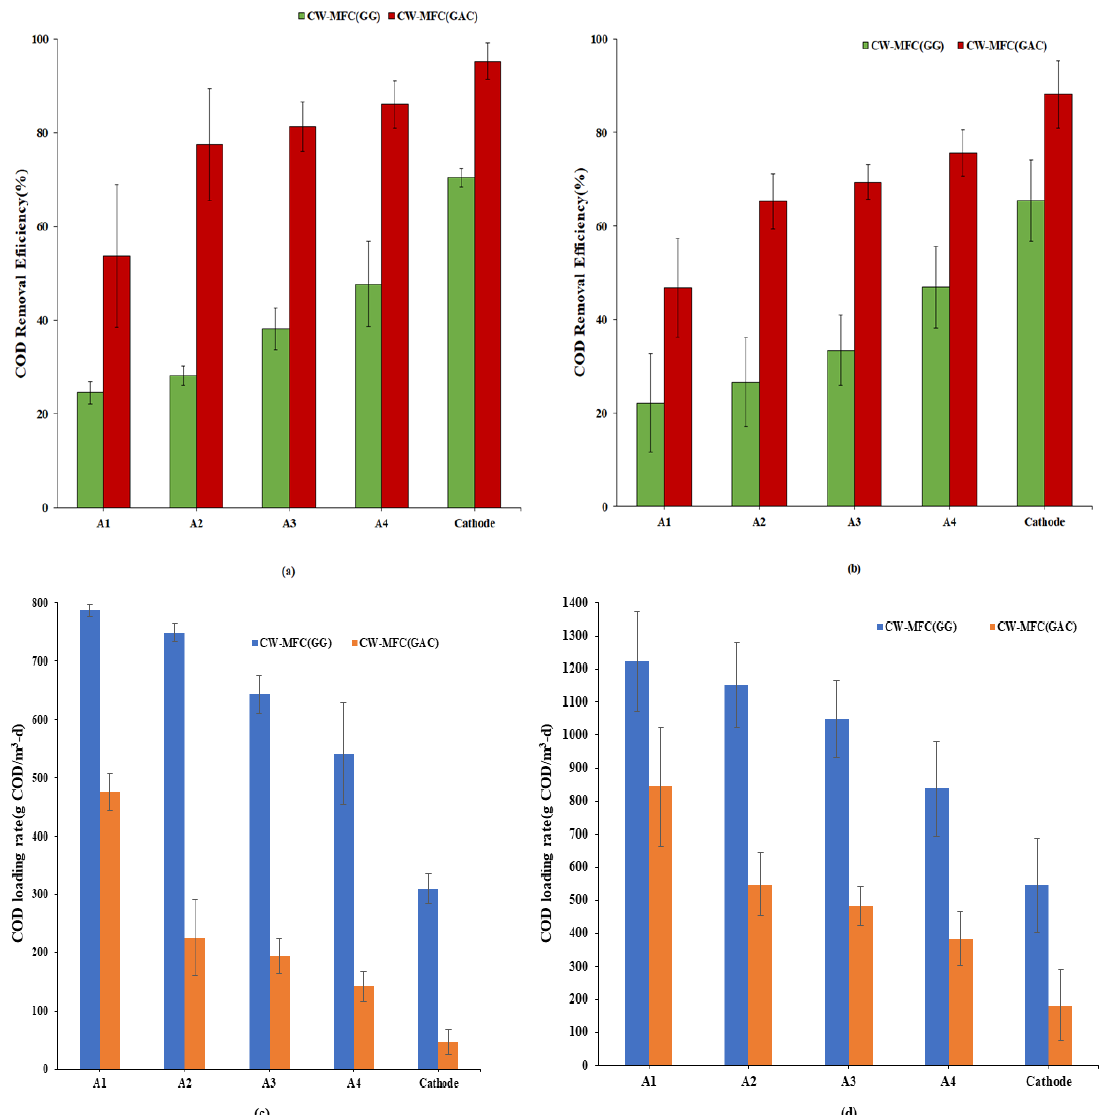
Figure 3. COD Removal efficiency (%) at an ( a ) organic loading rate of 890.11 g COD/m 3 -d and ( b ) organic loading rate of 1781.32 g COD/m 3 -d, ( c , d ) show COD loading rates from A1 to Cathode for an organic loading rate of 890.11 g COD/m 3 -d and 1781.32 g COD/m 3 -d, respectively.